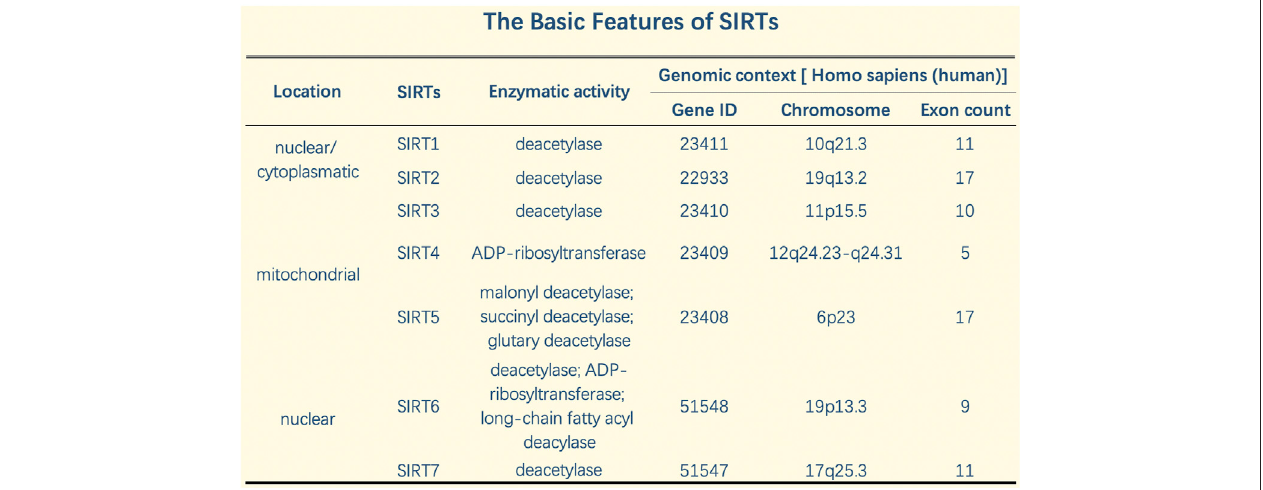
FIGURE 2 | The basic features and genomic context of SIRTs.